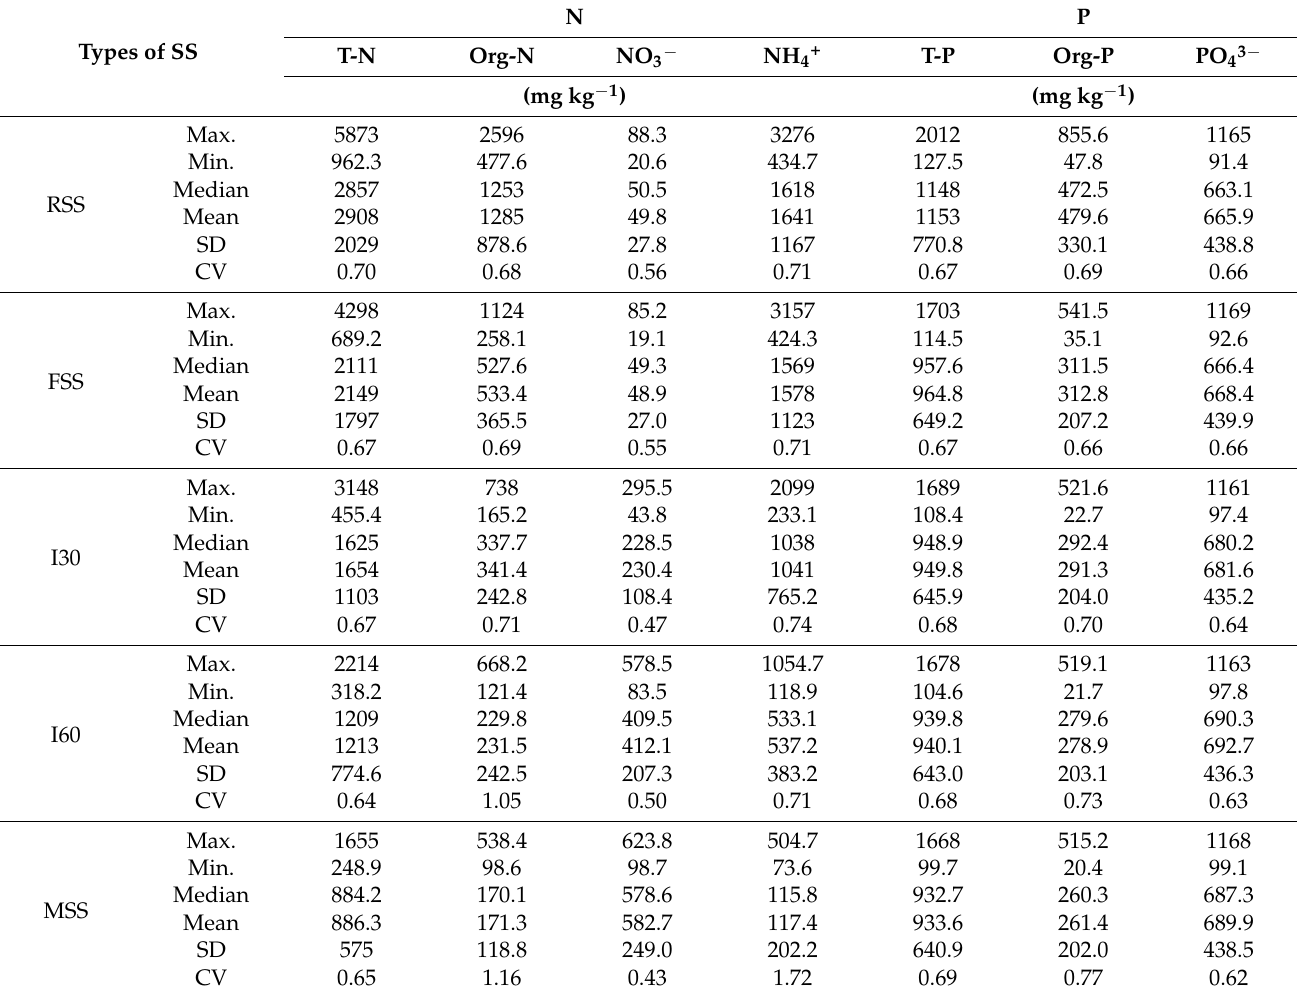
Table 5. Variation in content of N and P in swine slurry samples from each stage of